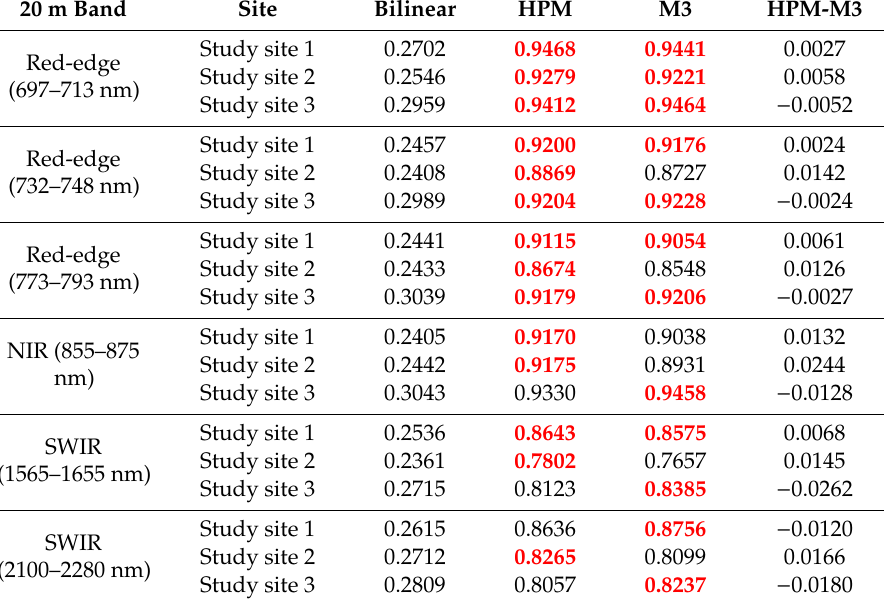
Table 6. Study site Q 2 n values derived considering the six Sentinel-2 20 m sharpened bands independently ( n = 1). The highest Q 2 n value (least distortion) for each study site is shown in red bold font, and if values are within two decimal places (i.e., | HPM-M3 | < 0.01), then both are shown in red